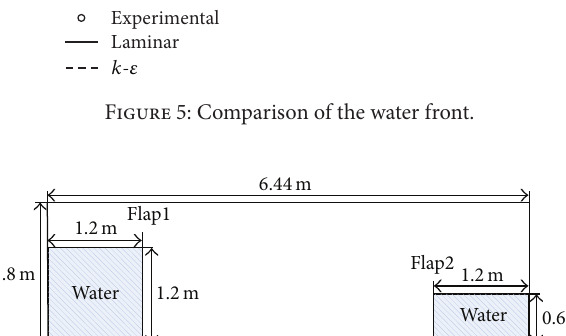
Figure 6: Simulation model and asymmetric fluid